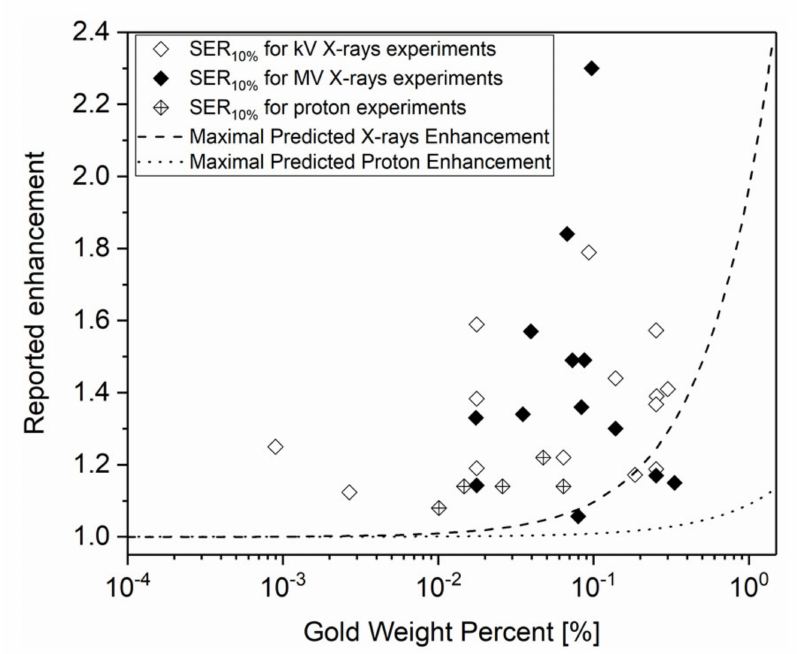
Figure 3. Comparison of observed in vitro experimental sensitization enhancement ratio (SER) with predicted dose enhancement values for GNPs studies. Dashed line represents maximal X-ray predicted enhancement calculated on a 1 DEU.WP − 1 basis. Dot line represents maximal proton predicted enhancement calculated on a 0.09 DEU.WP − 1 basis. Gold weight percent was calculated based on a theoretical eukaryotic cell volume of 3000 µ m 3